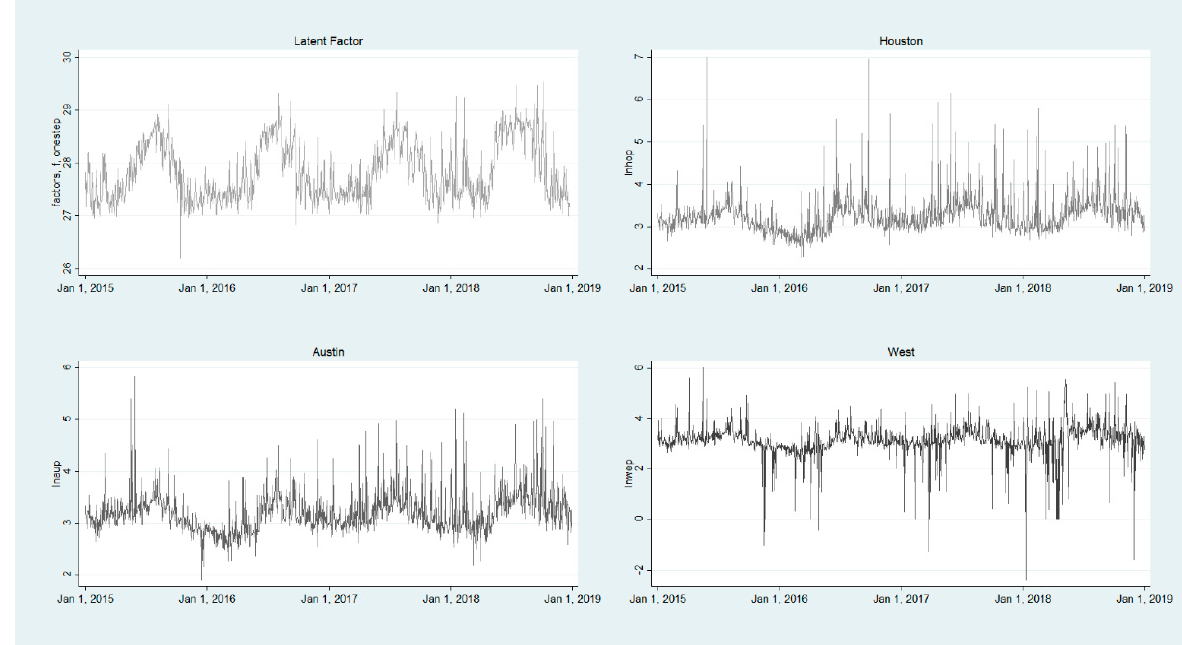
Figure 5. 12:00 p.m.—Latent Factor and Houston price series (top left and right); Austin and West (Bottom left and right).